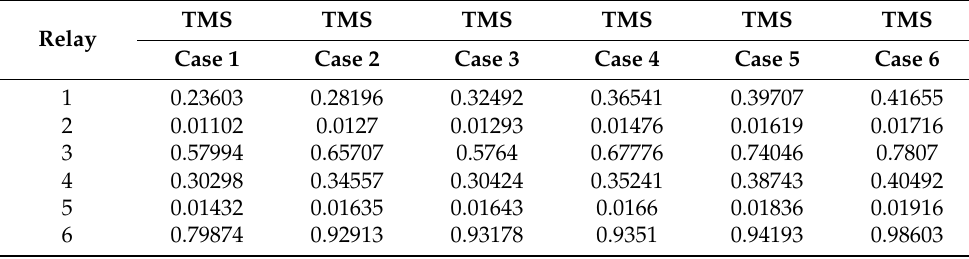
Table 4. Relay TMS parameter optimization using the hybrid GWO-PSO